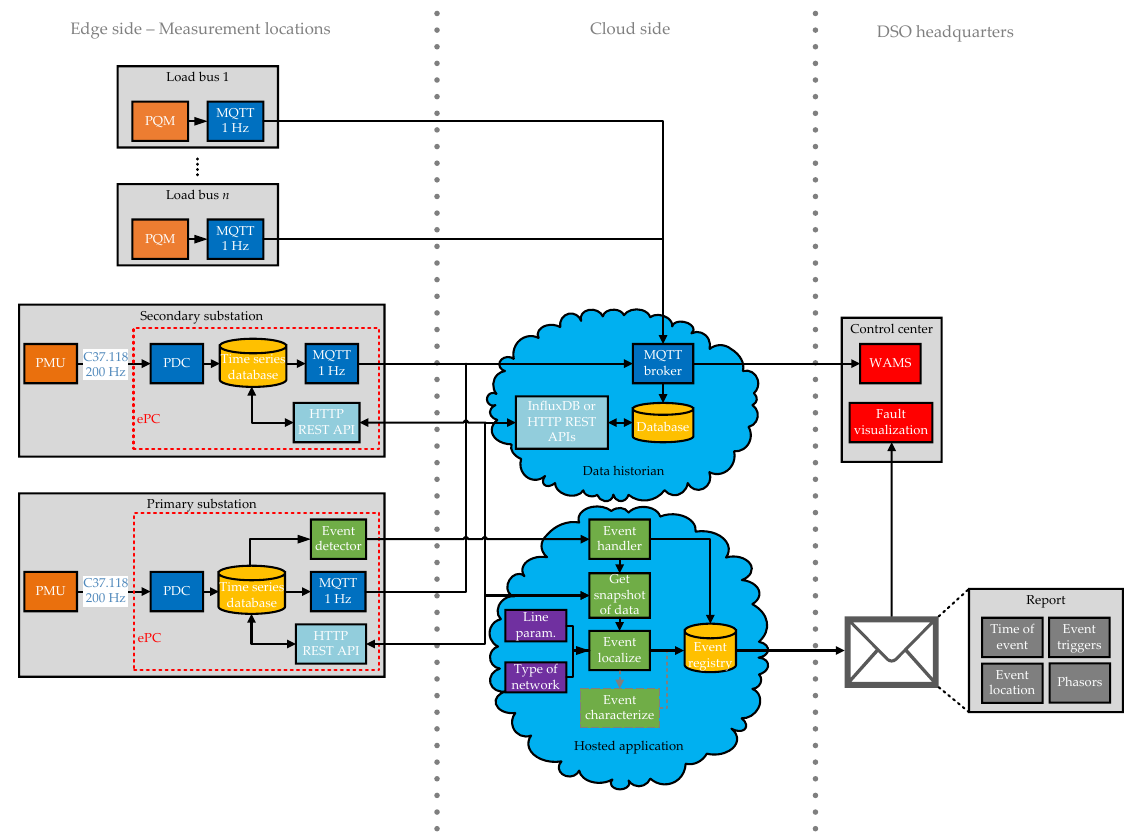
Figure 5. Edge-cloud computing framework for automated fault localization.